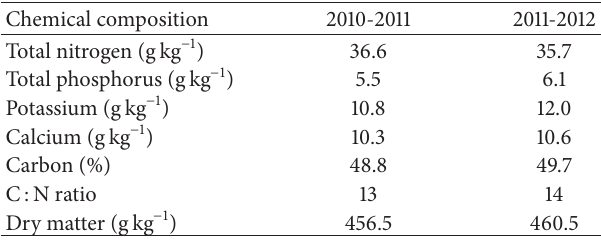
Table 2: Chemical composition of Lablab green manure used at Samaru in 2010-2011 and